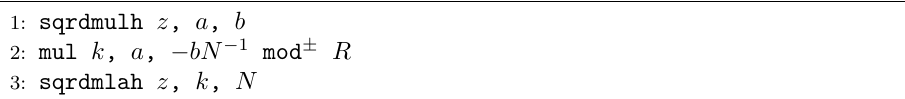
Algorithm 13 Montgomery multiplication with rounding.